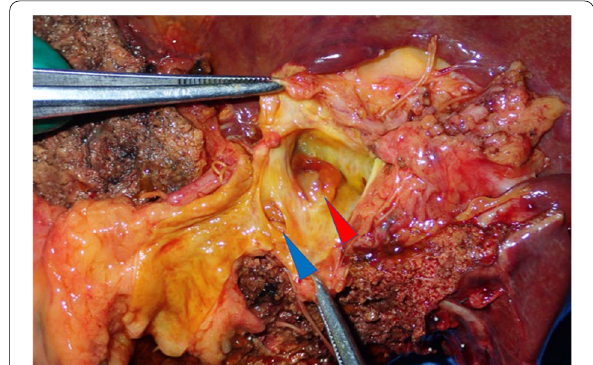
Fig. 3 Photograph of the resected specimen (first surgery). The papillary tumor (red arrowhead) in the left hepatic duct was close to the opening of the posterior segmental branch of the hepatic duct (blue arrowhead)